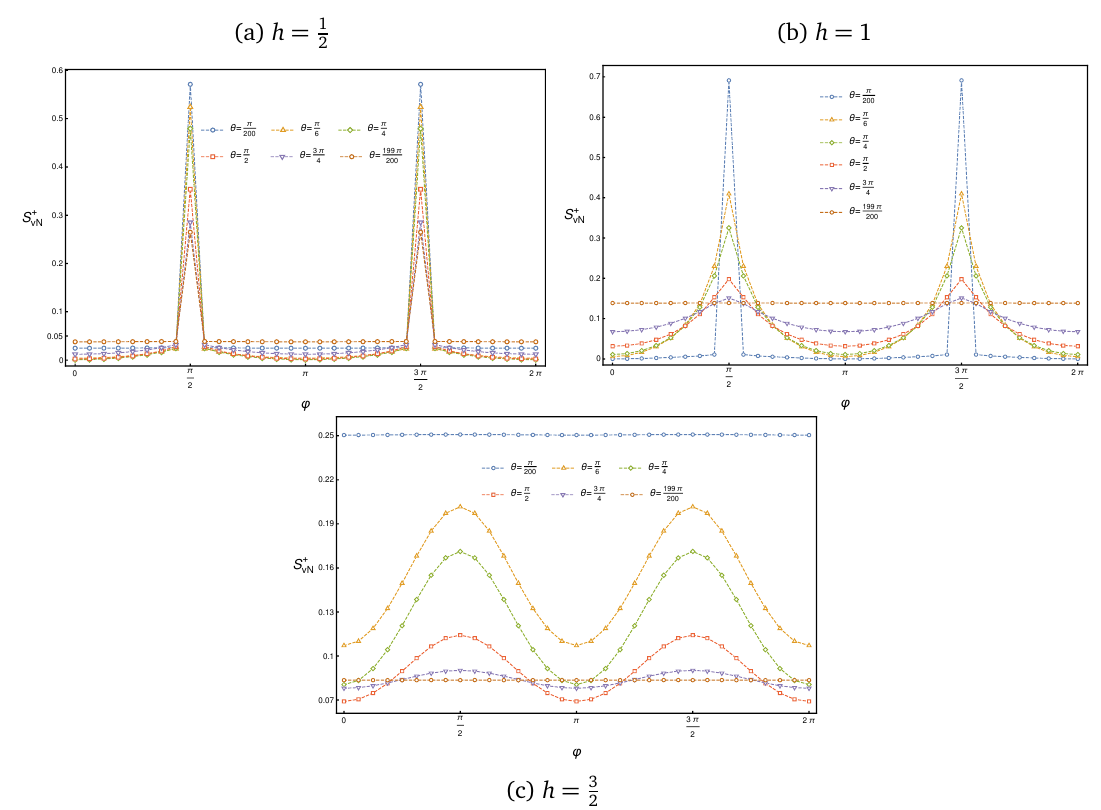
Figure 6: In this figure, the von Neumann entropy is plotted with respect to the angles of BMF, for three values of magnetic field, h = 1 , 1, 3 respectively. We have 2 2 = b = sin ( θ ) cos ( ϕ ) , b = b = sin ( θ ) sin ( ϕ ) and b = b = cos ( θ ) . put b L , x L , y L , z 1, x 1, y 1, z Rest of parameters are: L = 30, l = 2, β = + 1, J = − 1 and γ = 1. To better manifest the change in the entanglement entropy, size of the subsystem is selected to be close to the beginning of the chain. We observe that there is a change in the entanglement π π at ϕ = , 3 . As mentioned before, there is (one) more zero mode in the eigenvalues 2 2 of M matrix in (9) for h > 1. However, this is not an exact zero mode and for size L = 30, it is small but not zero. Therefore, observation above is